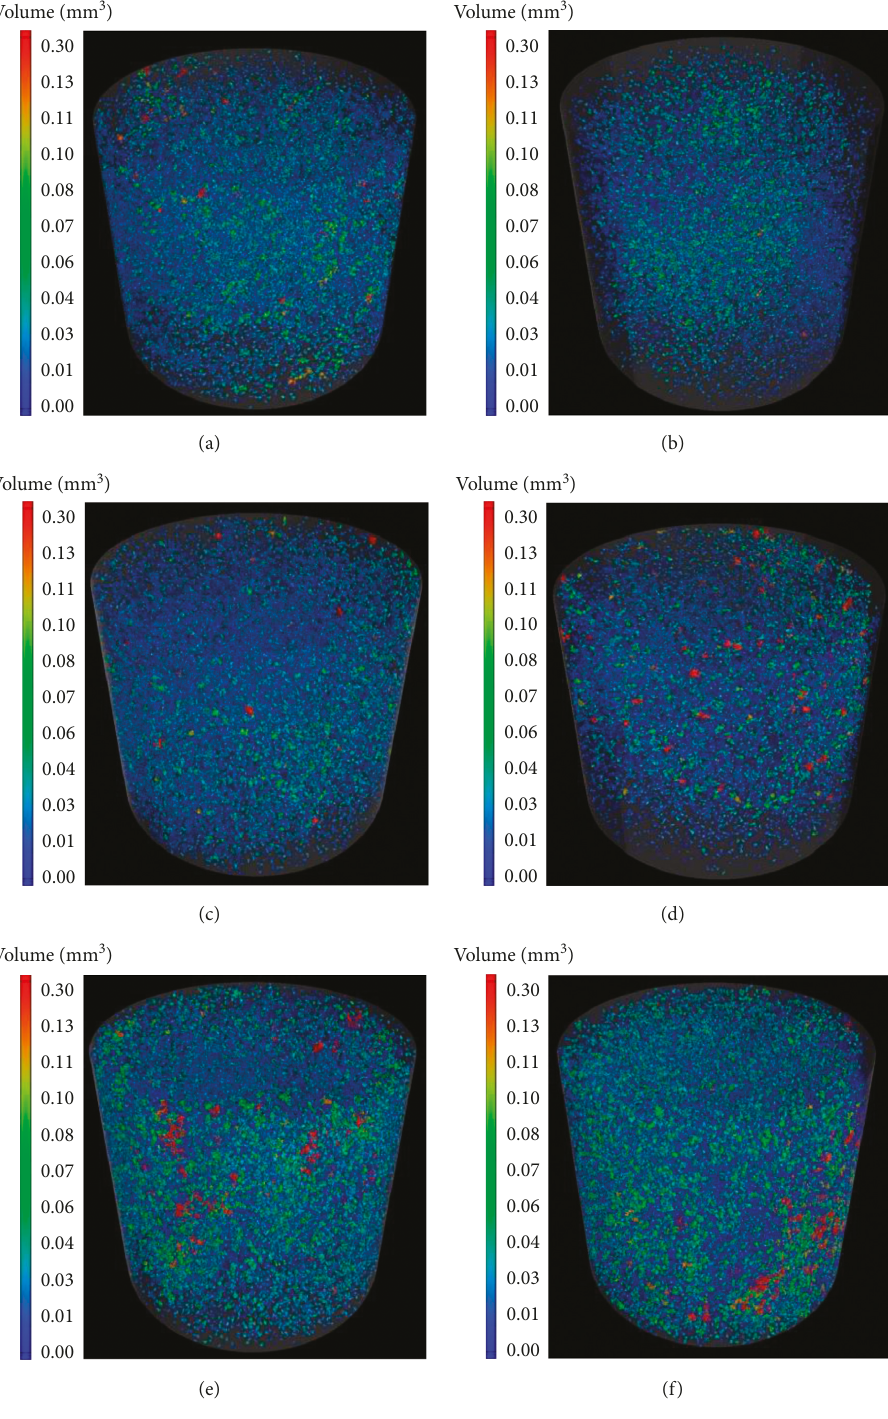
Figure 11: Crystal size changes at different